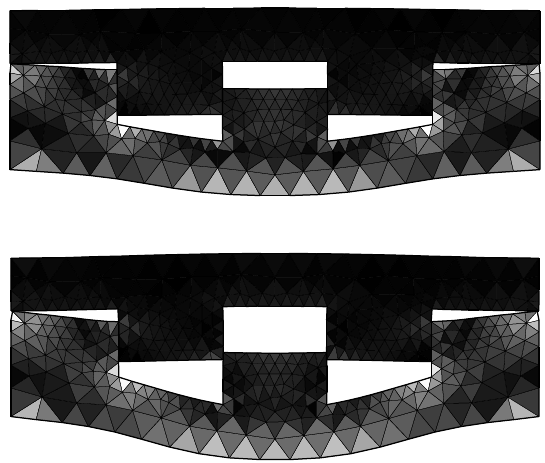
Figure 6.14 . Tresca criteria for the stresses in the viscoelastic ( 0 . 5 , 0 . 2 ) and elastic